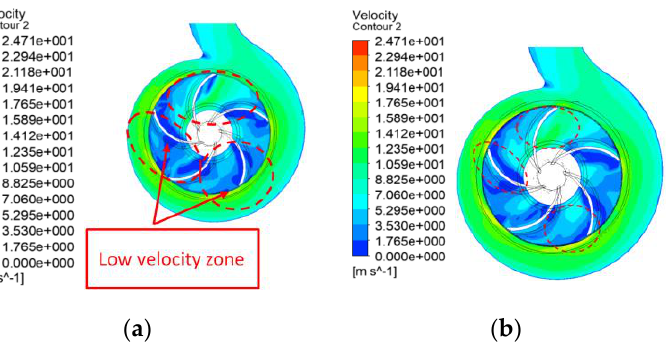
Figure 10. Velocity contours of flow region at 1000 rpm. ( a ) Original model; ( b ) rounded model.